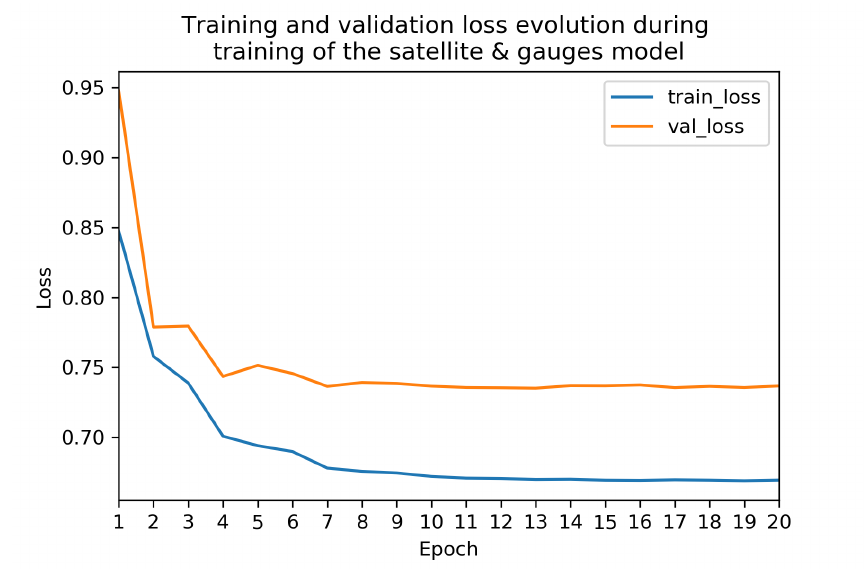
Figure 8. The evolution of the training and validation loss during the training of the